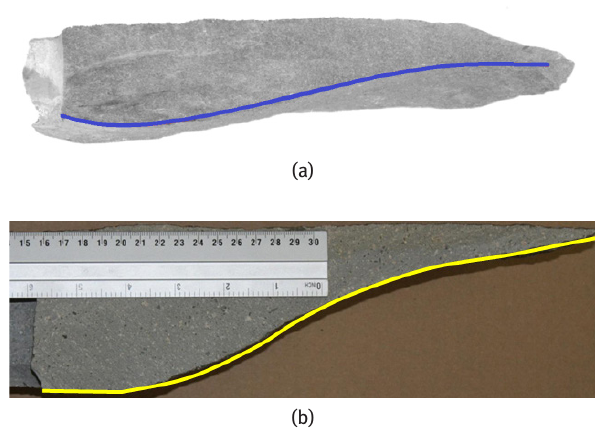
Figure 14: A cross-section of the actual pull-out sample: a) Sandstone,